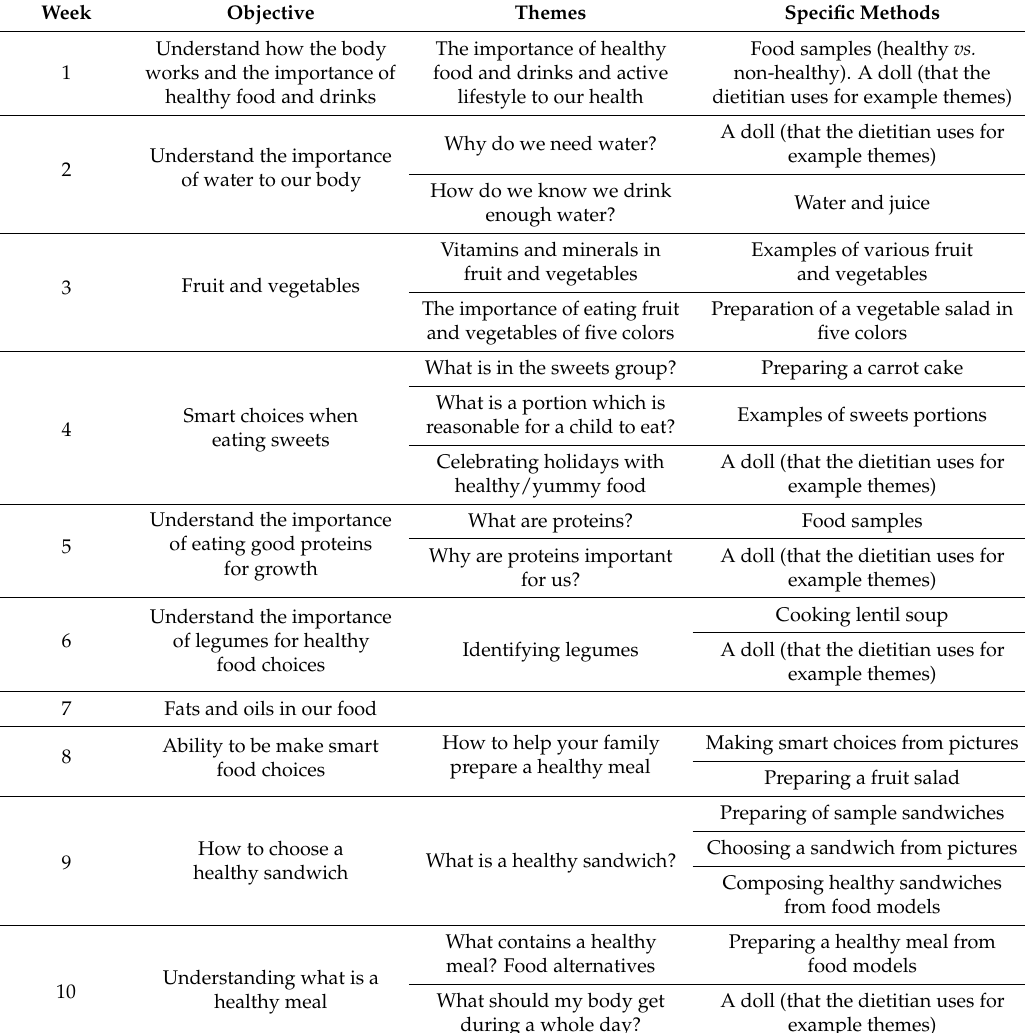
Table A1. Children’s nutrition intervention program (full intervention model)